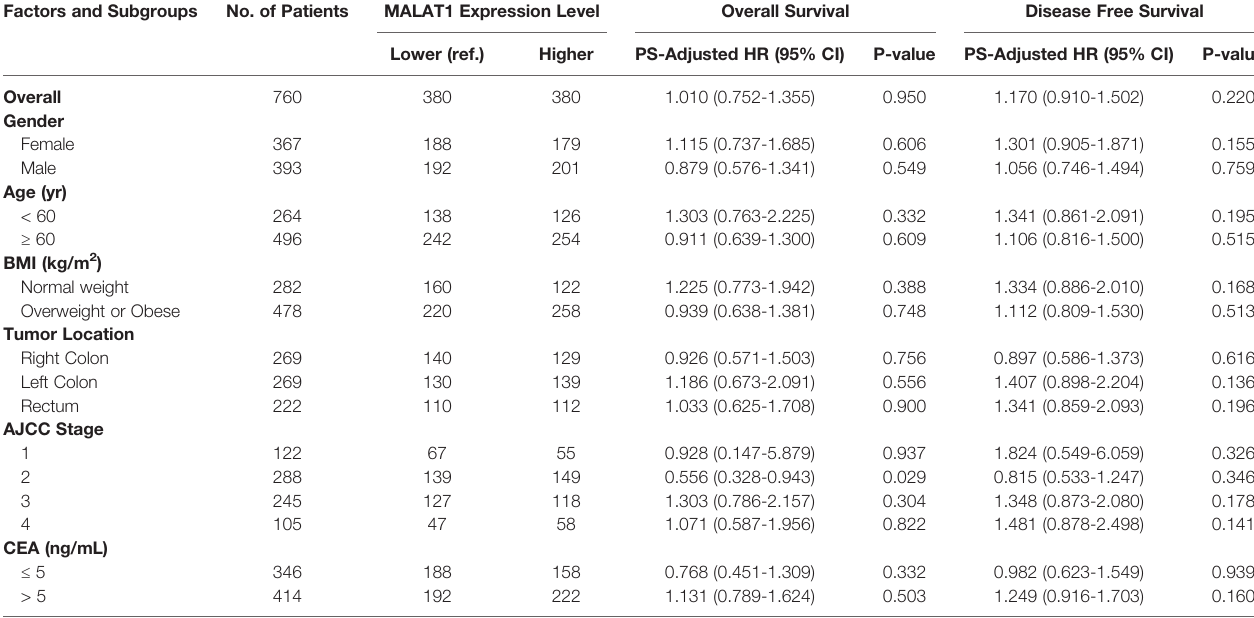
TABLE 3 | Prognostic associations of MALAT1 expression and colorectal cancer outcomes in the combined populations. Factors and